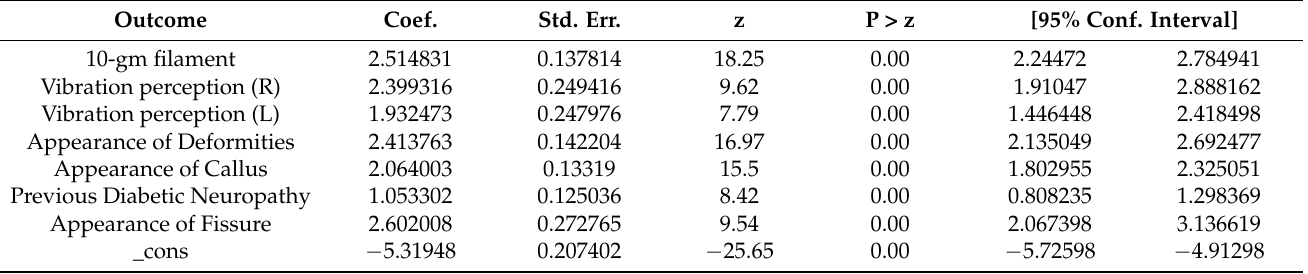
Table 3. Logistic regression analysis for constructing the nomogram to predict DSPN utilizing the top 7 variables by the extra tree feature ranking